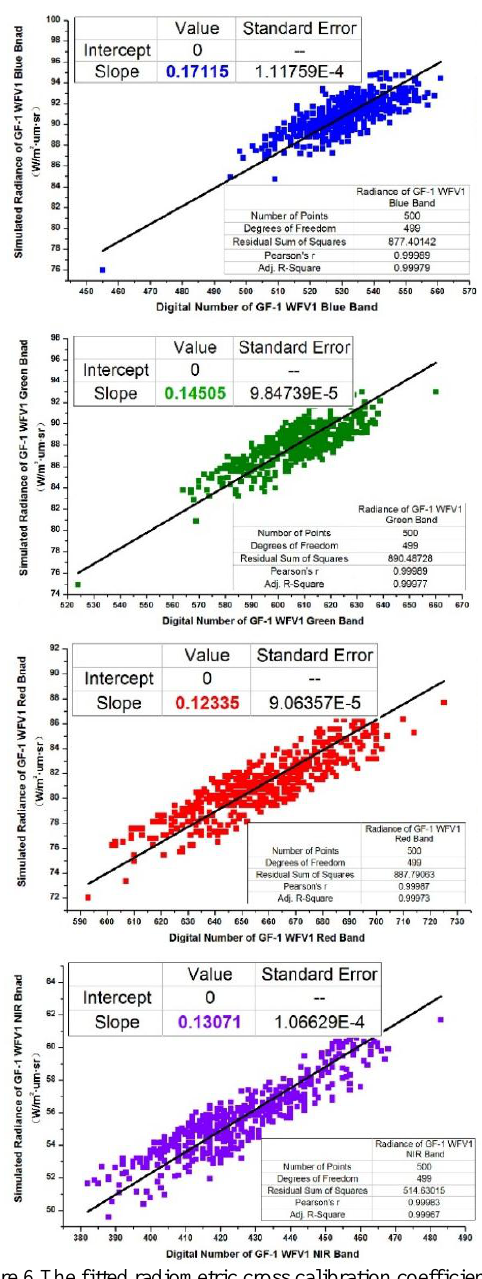
Figure.6 The fitted radiometric cross calibration coefficients of WFV1 camera